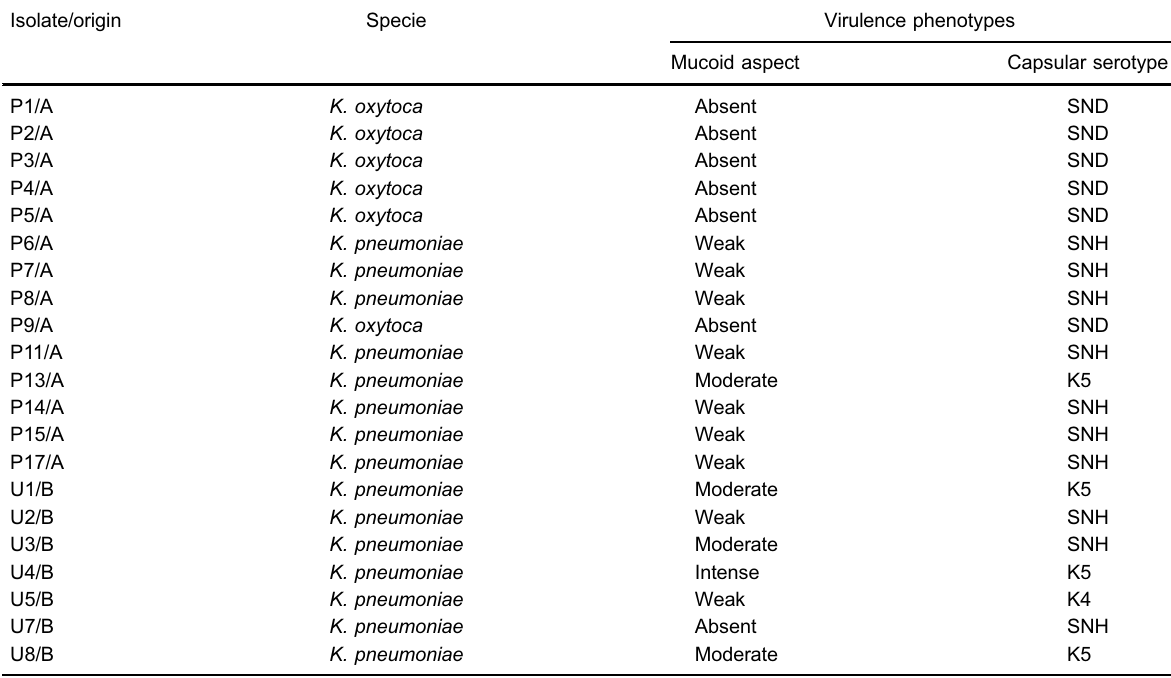
Table 1. Virulence phenotypes of Klebsiella isolates from modular enteral diets.